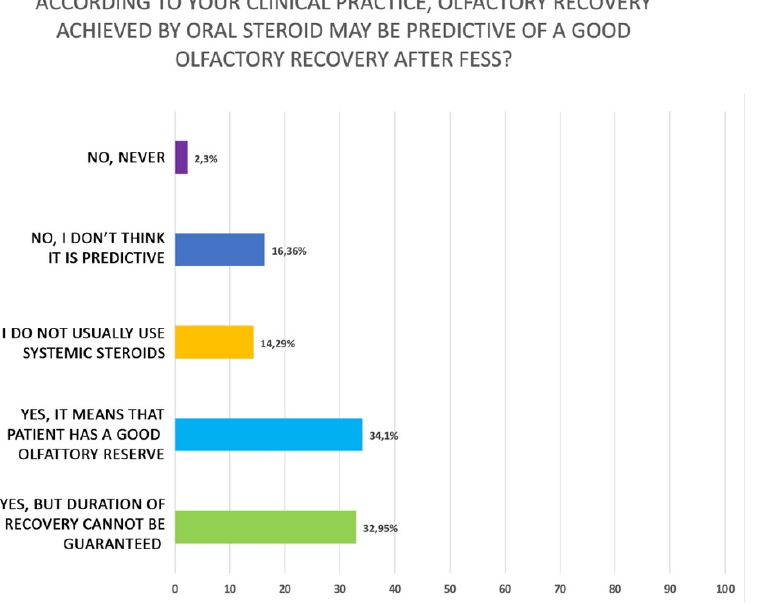
Figure 7. Perceived efficacy of oral corticosteroids on long-term control of olfaction (Q37 of Supple- mentary Materials File).